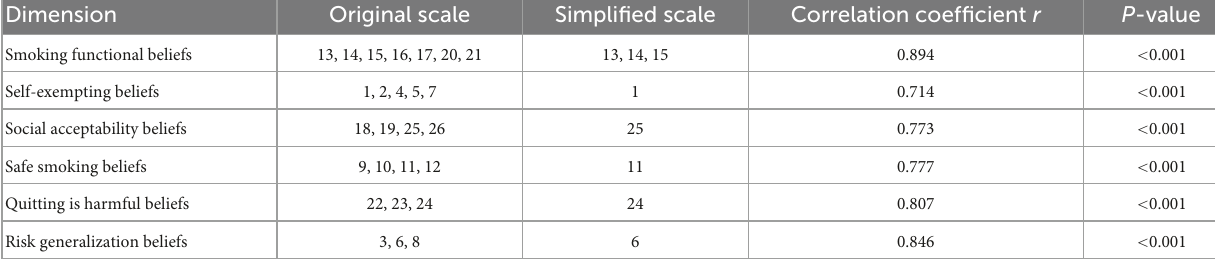
TABLE 5 Correlation analysis of dimensions between the original scale and the simplified